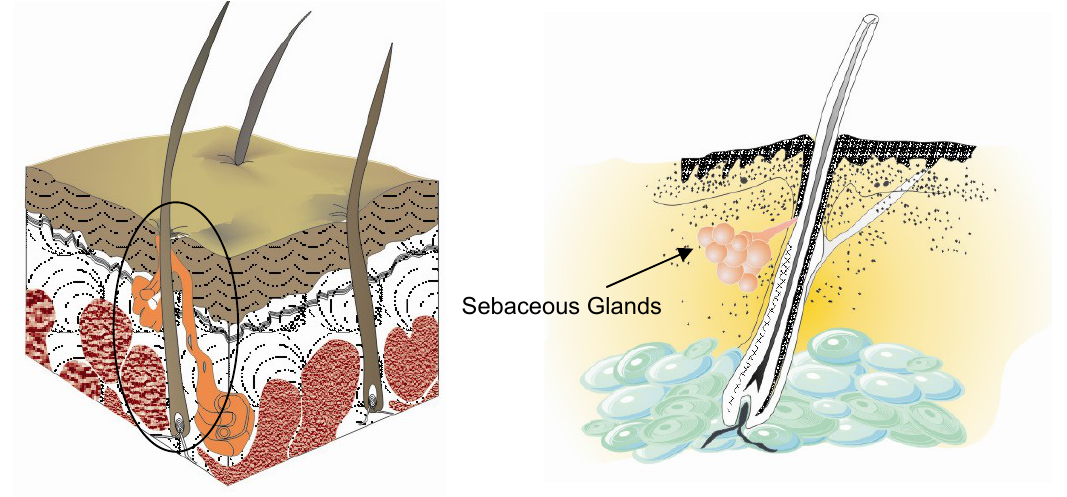
Figure 2. Sectional view of the skin with sebaceous glands.